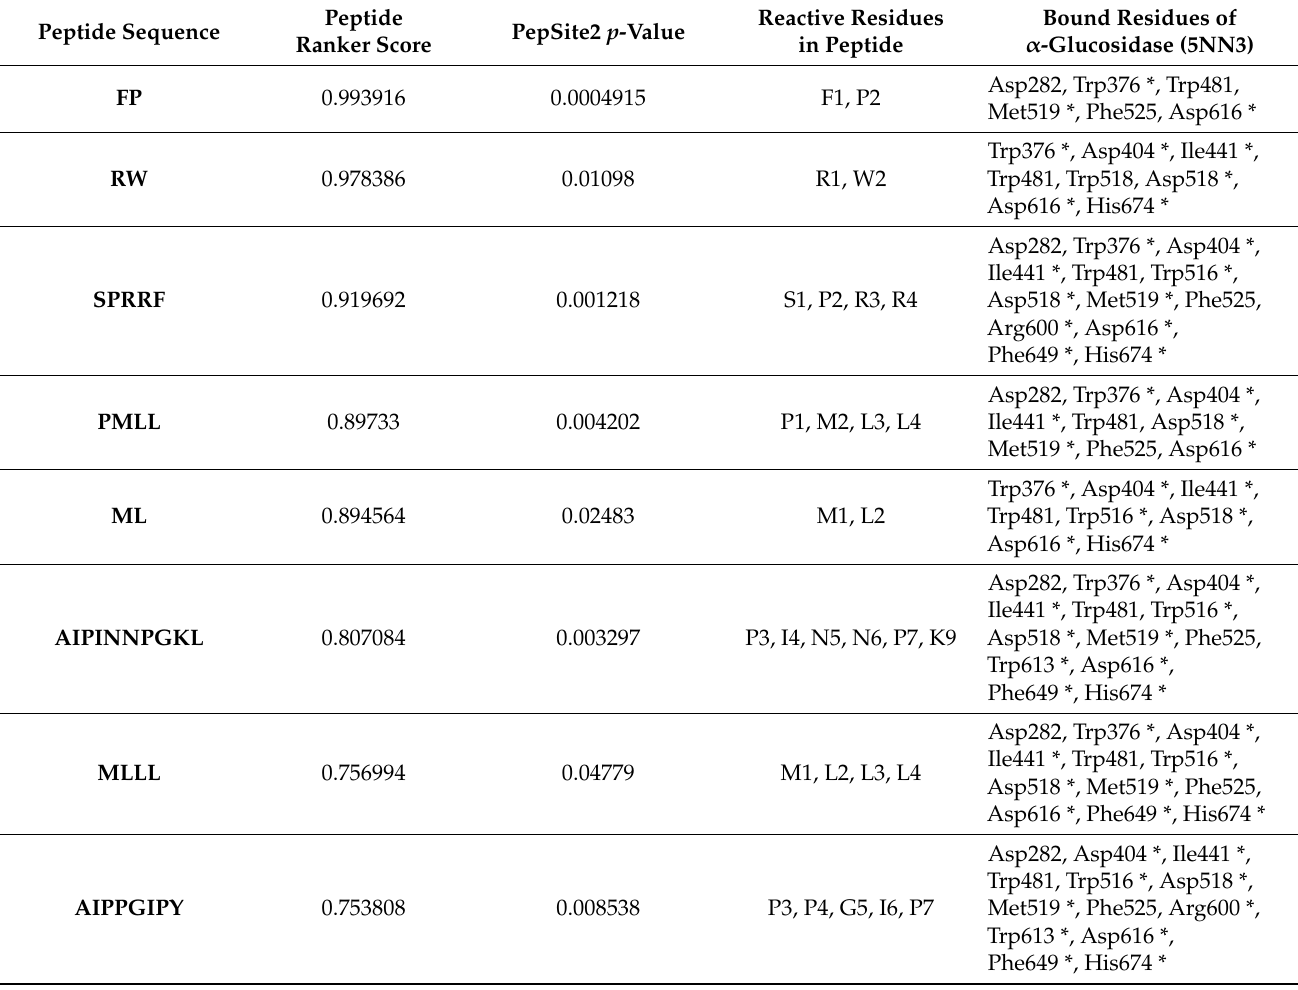
Table 2. Biologically active peptides from a selected lupin protein hydrolysate (ACT) and their binding potential with α -glucosidase (5NN3) as a protein receptor. Peptide